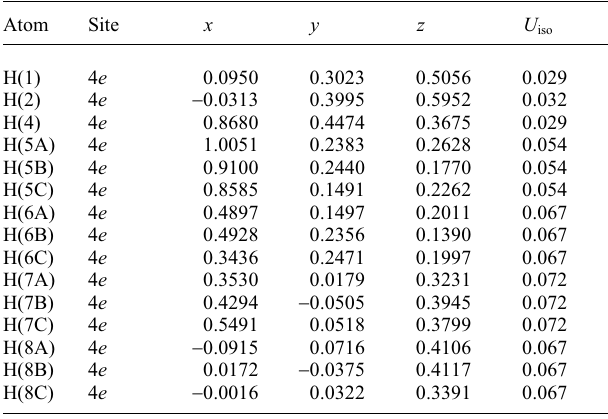
Table 2. Atomic coordinates and displacement parameters (in Å 2 )